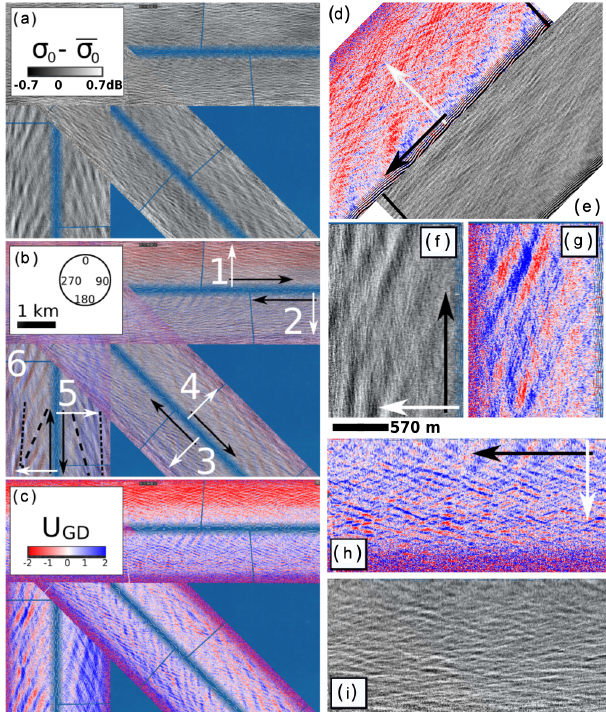
Figure 9. (a, c) Mosaics of KuROS backscattering intensity and Doppler velocity data acquired on 22 November with fixed port- looking antenna. (b) Overlay of the Doppler velocity and backscat- tering intensity. Flight tracks are numbered 1 to 6; black arrows in- dicate the flight direction, and white arrows point in the radar look direction. The long dashed lines represent the apparent direction of swell crests. Panels (d) – (i) show close-up views of selected tracks from (a) and (c) . The tracks shown in (d) and (e) are out of the frame of (a) and (c) . Panels (f) – (i) show close-ups of flight tracks 6 and 2. The 570m scale bar applies to (f) – (i) and corresponds to the along- track 3dB width of the radar beam at a 12 ◦ incidence angle, i.e., near the middle of the swath. The mean trend of σ 0 as a function of θ has been removed from the σ 0